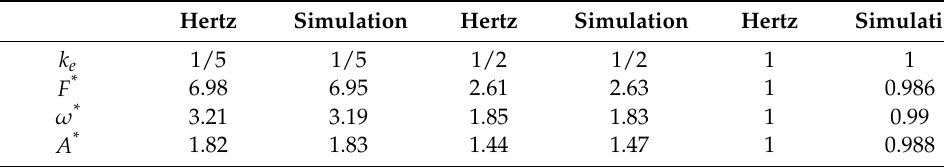
Figure 3. Stress–strain relationship for isotropic strain hardening materials. Table 2. Comparison of Hertz and simulation